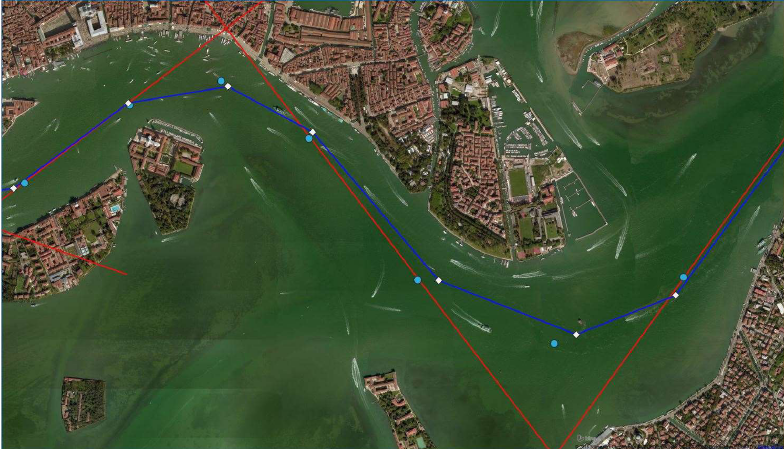
Figure 12. Differences between the WP of the analytical method (light blue dots) and statistical method (white diamonds).